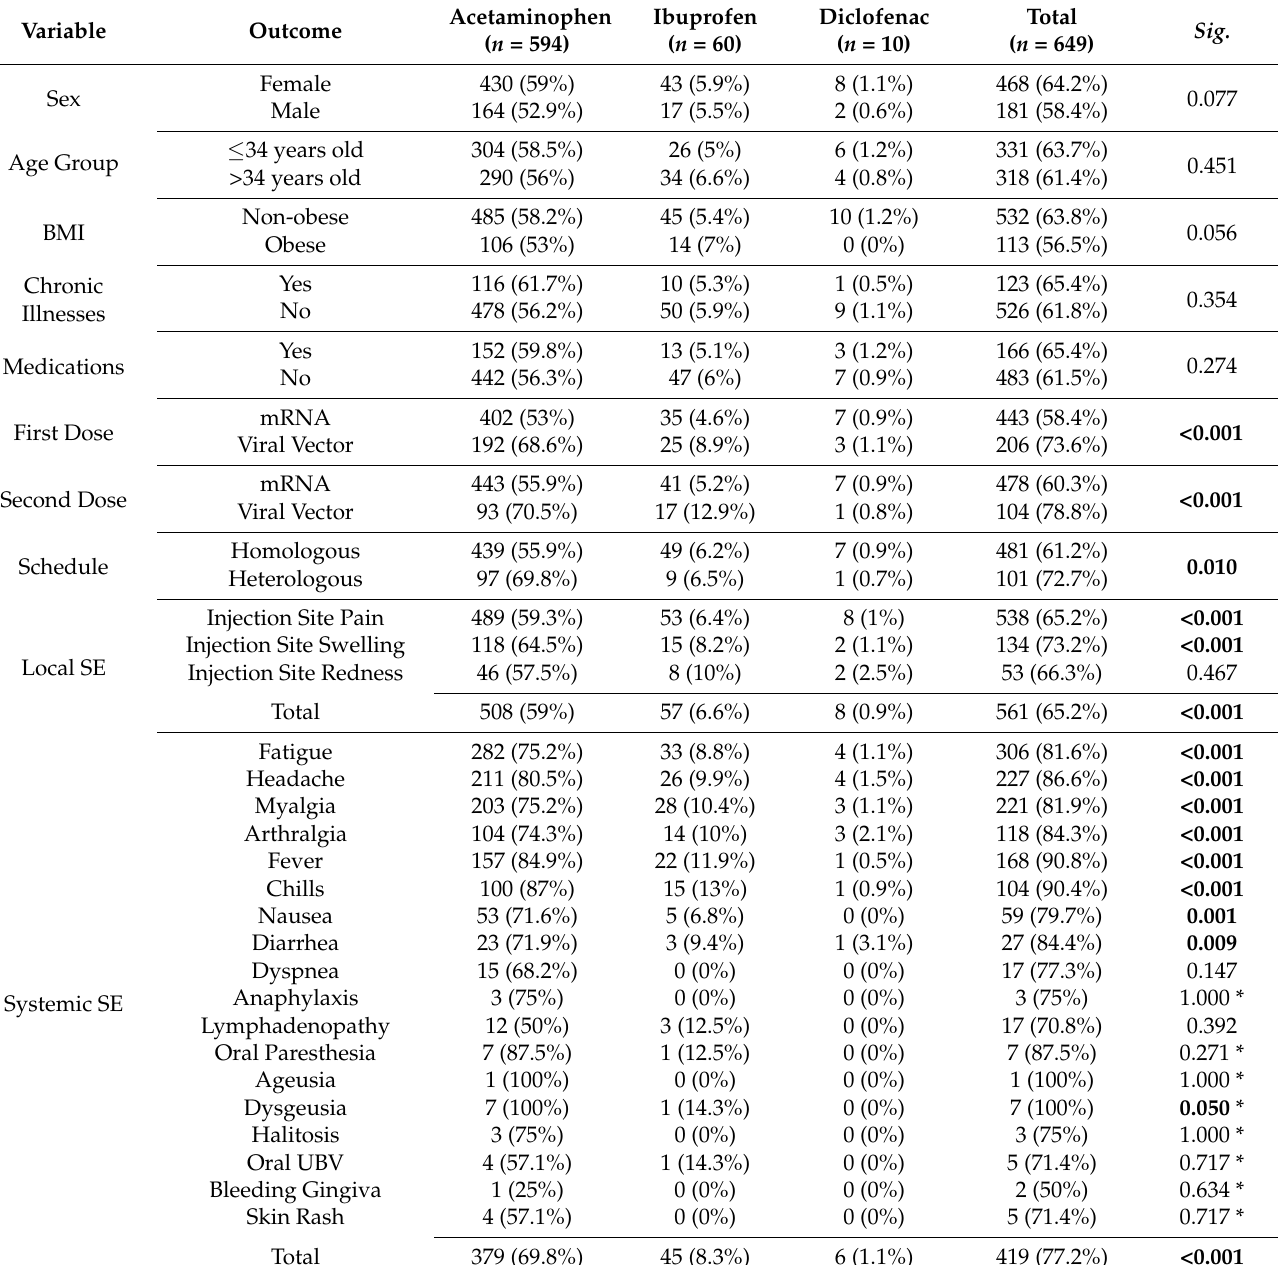
Table 3. Prevalence of Medications Consumption Following COVID-19 Vaccination Reported by Saudi Healthcare Workers Responding to CoVaST-SA, ( n =